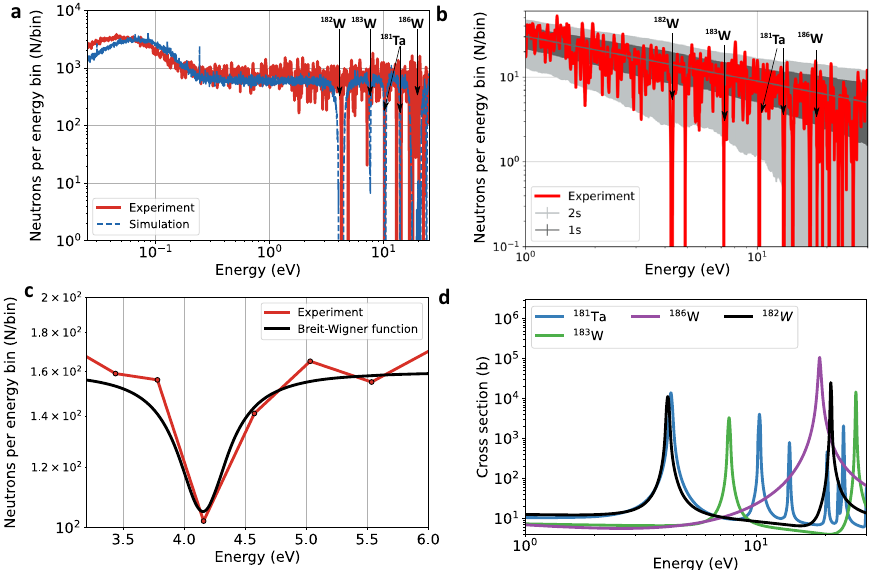
Fig. 4 Neutron resonance spectroscopy with a LDNS. a Measured neutron spectrum after transmission through a tungsten sample (red) and PHITS simulation (blue). Both in the experiment and the simulation, the isotopes 182 W, 183 W, 186 W, and 181 Ta can be identi fi ed. b The measured NRS signal is plotted (red) with the moving statistical fl uctuation from the fi t function 30 ⋅ E (cid:2) 0 : 53 n to assess the statistical signi fi cance of the isotope identi fi cation. The dark area corresponds to 1 σ and the light gray area to 2 σ deviation. c Measured neutron fl ux at the 182 W resonance (red) with an increased bin width. The Breit – Wigner function (black) of the resonance of 182 W with the position of 4.15 eV and the FWHM width Γ = 0.55 eV is in good agreement with the measurement. d All relevant resonances for tungsten and tantalum in the range of 1 – 25 eV using ref. 2